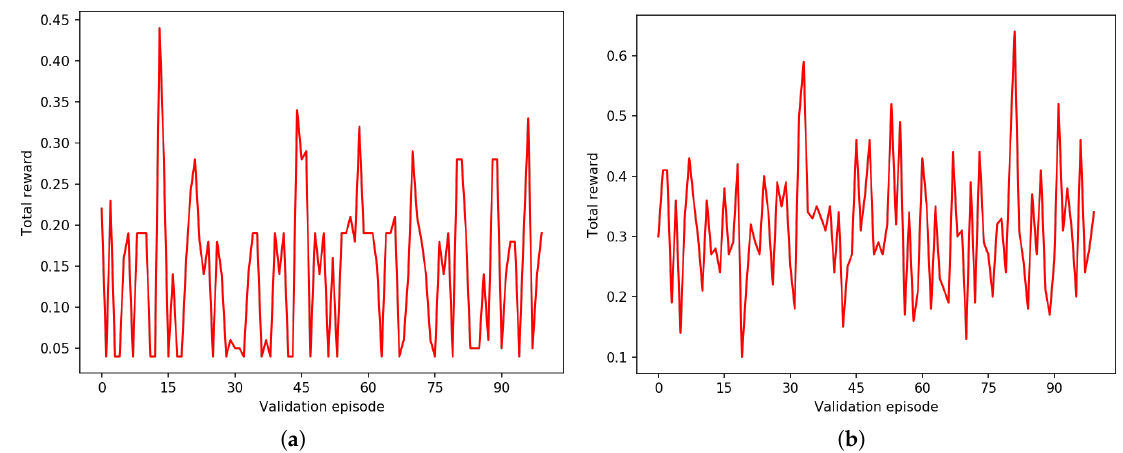
Figure 8. Average total rewards of a random agent on BF and RF for short sequences. ( a ) ρ BF with B = 80, episodes length T = 40. ( b ) ρ RF with N = 2, episodes length T = 100.